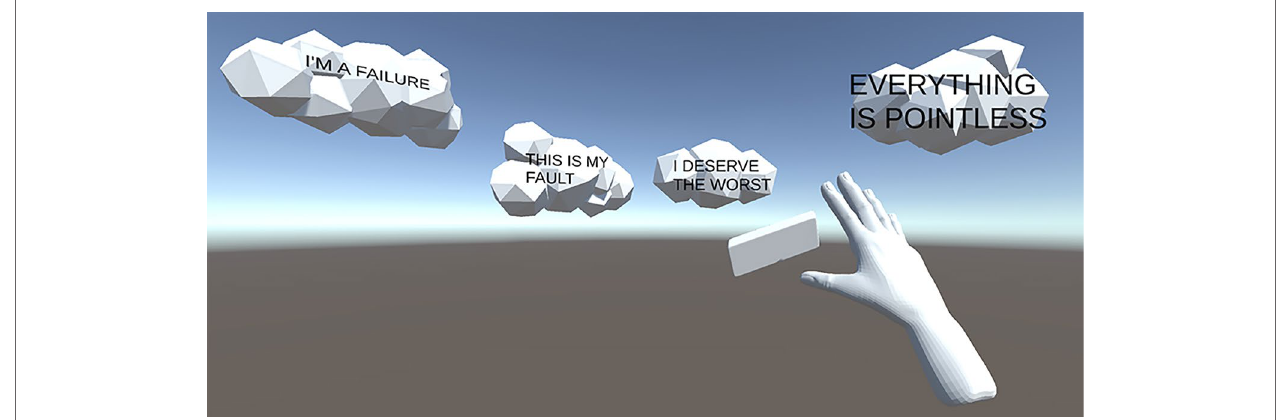
FIGURE 1 | Mockup of using VR for hands-on cognitive